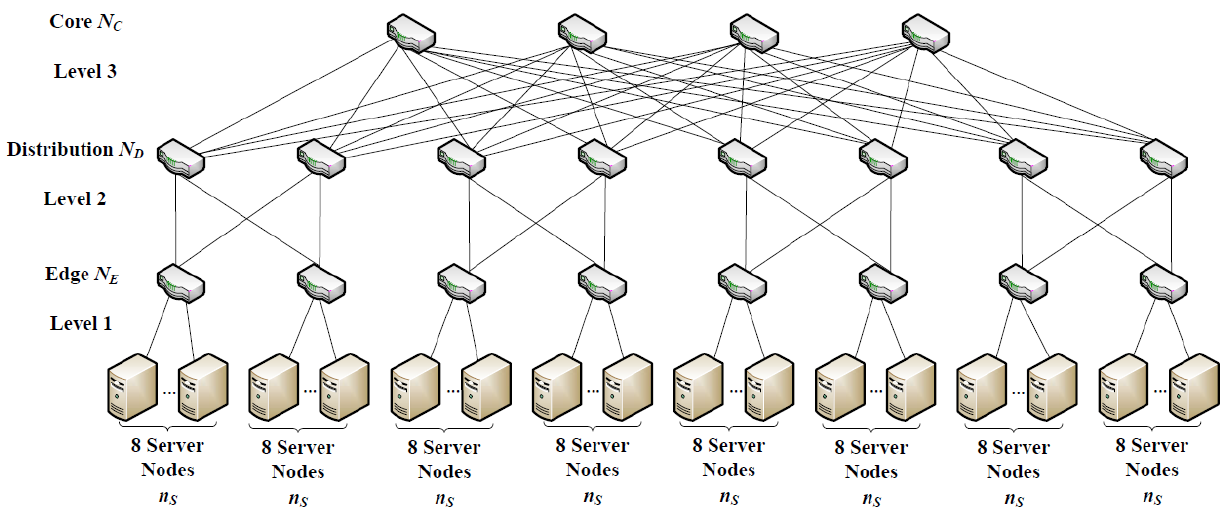
Figure 2. Physical network topology of the cloud computing environment adopted in the simulation.